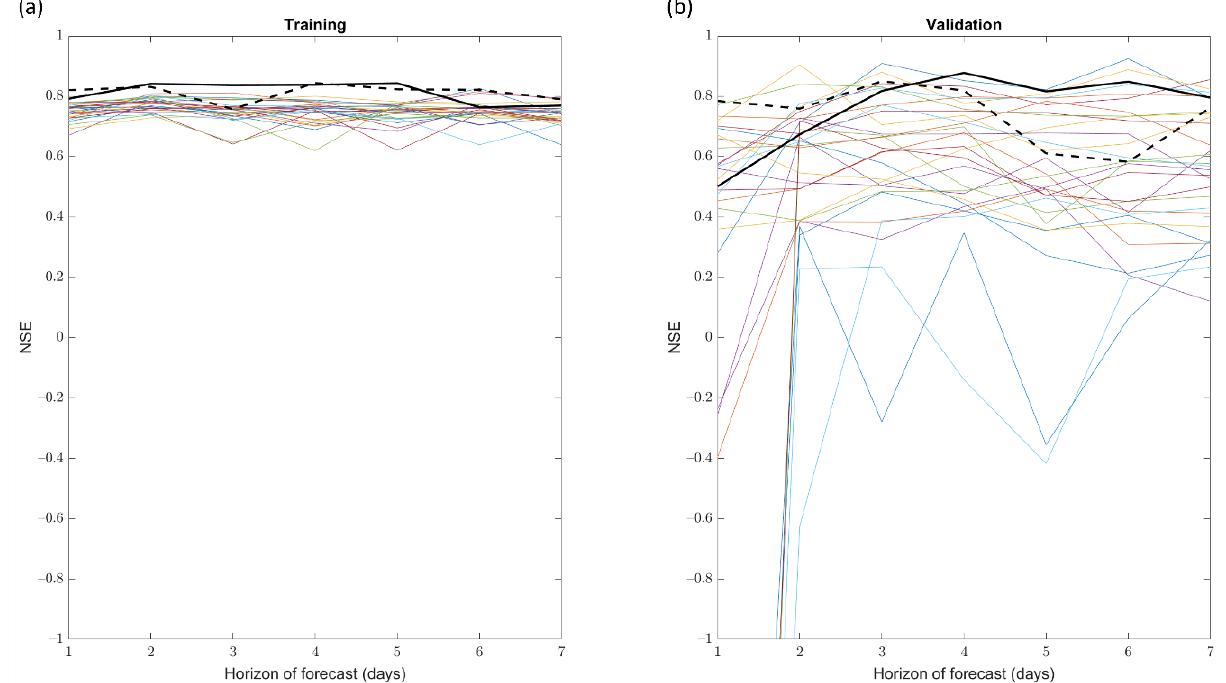
Figure 14. NSE evolution for the Androscoggin watershed in 2009. ( a ) Training, ( b ) Validation. Colored lines for each pixel, dotted line for the distributed model, and full line for the global one.